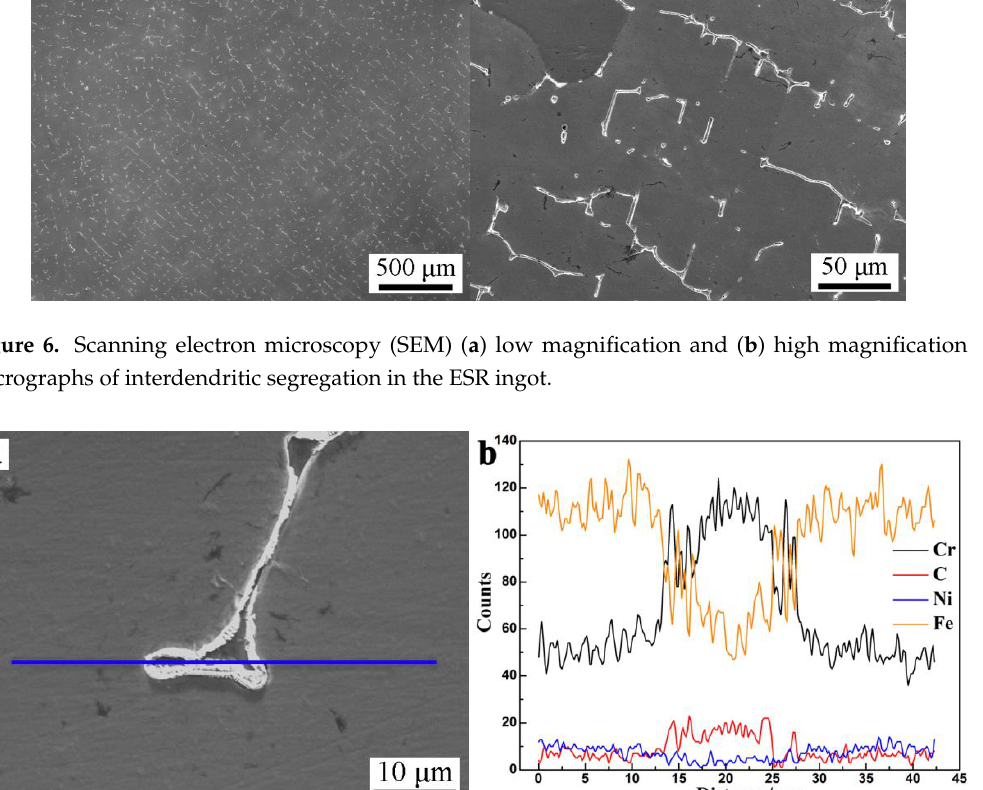
Figure 8. SEM images of dendrite segregation distribution in the ( a ) Spec. A, NiCrMoV, ( b ) Spec. B, TZ, and ( c ) Spec. C, CrMoV. The SEM micrograph and EDS spectral image of precipitates observed in the ESR ingot are shown in Figure 9. Figure 9a shows that precipitates distribute randomly, and the size of the big precipitates is up to about 40 μm. The corresponding EDS analysis reveals the precipitates mainly consist of C, Cr, Ni, and Fe (Figure 9b). In order to analyze the precipitates in detail, TEM analysis were conducted to reveal the crystal structure of the precipitates. Figure 10 shows the TEM micrograph and the corresponding SAED patterns of the precipitates. According to the analysis of the SAED, the spots (311 — ) and (2 — 42 — ) correspond to M 23 C 6 with an FCC crystal structure in Figure 10b. The M 23 C 6 carbide is common in high chromium steel [18]. In the present work, the ingot contains 0.074%–0.106% carbon, and it belongs to hypoeutectoid steel. During the solidification of the ingot, the γ phase transformed to the α phase and the solid solubility of carbon in the α phase was lower,